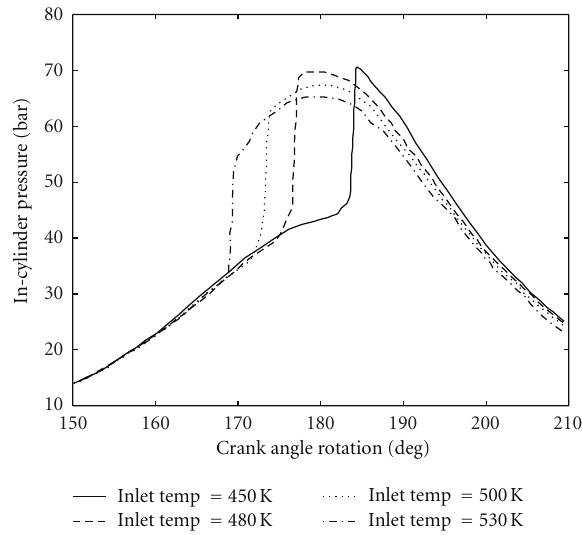
Figure 10: E ff ect of temperature variations on in-cylinder